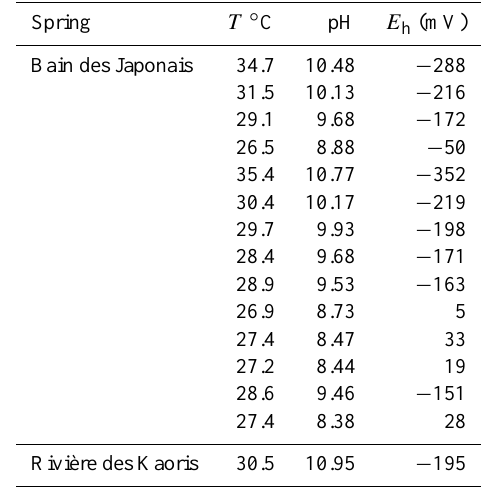
Table 4. Redox potential and pH measured in situ (24 April 2013) at the springs of the Bain des Japonais and of the Rivière des Kaoris. Spring T ◦ C pH E h (mV)